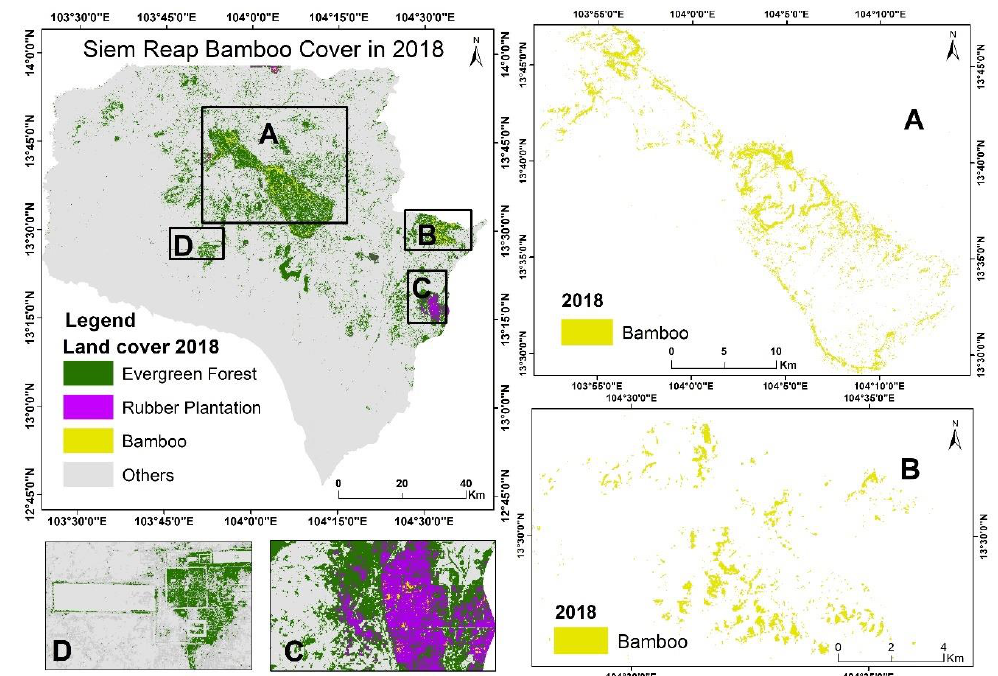
Figure 12. Maps showing the bamboo distribution in Siem Reap in 2018. Inset maps show natural distribution of bamboo in Kulen Mountain ( A ) and Boeng Peae Wildlife Sanctuary regions ( B ), rubber plantation in southeastern region ( C ) and evergreen forest around the Angkor Wat temple ( D ).